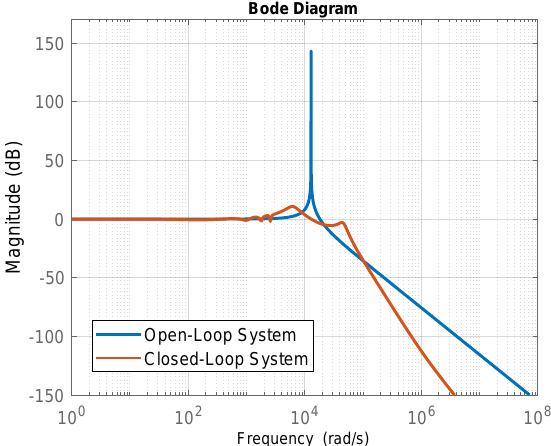
Figure 17. Open-loop and closed-loop frequency responses of the generation system 1 with the LC filter resonance